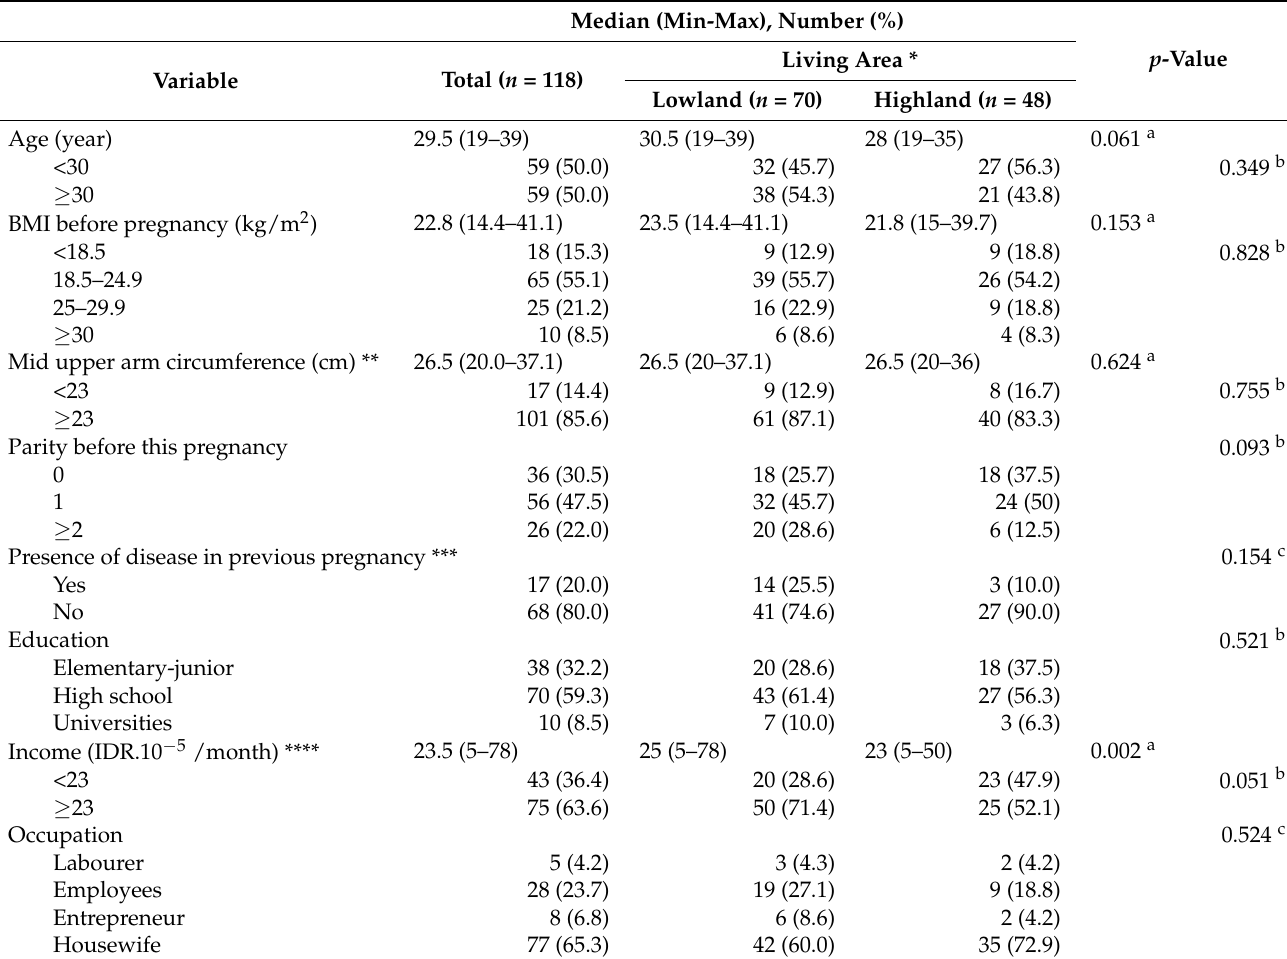
Table 1. Maternal characteristics of the study